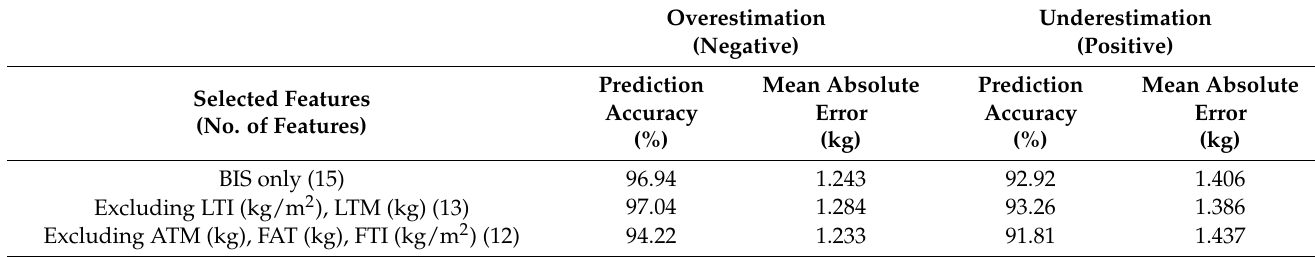
Table 5. Comparison of prediction accuracy of DW CP using linear regression by fat and muscle feature groups only on BIS features for − 15 kg < DW CP-BIS < 15